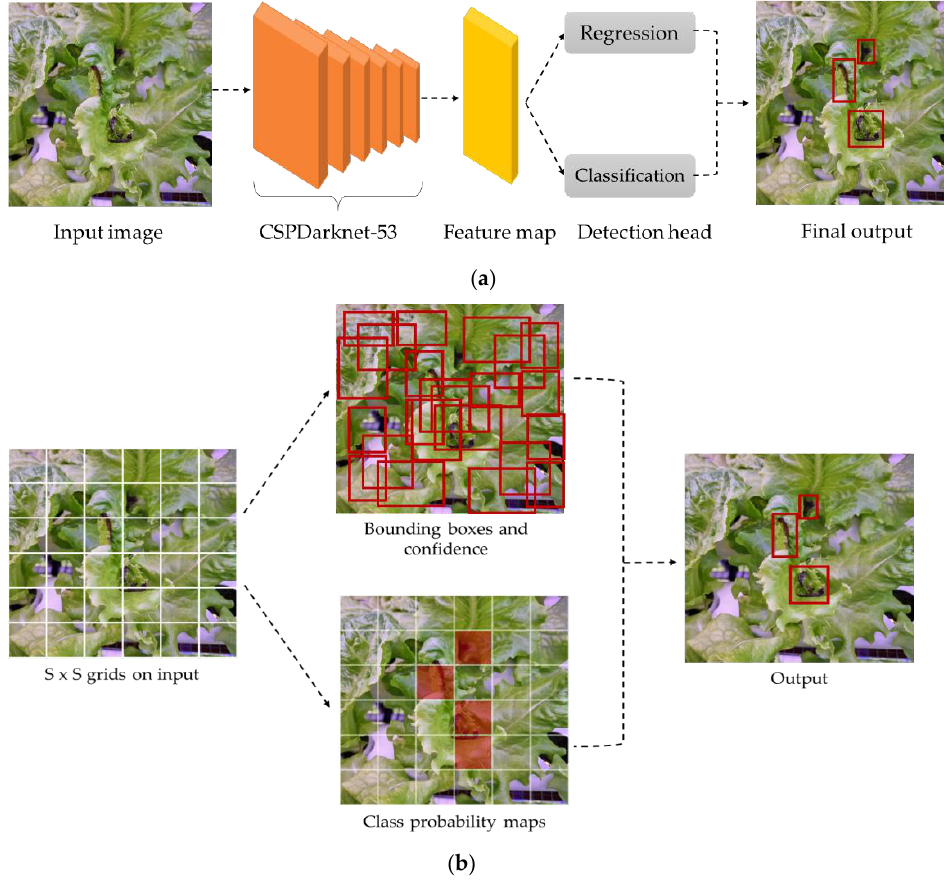
Figure 4. Working principle of the YOLO model: ( a ) detection process of YOLO model based on backbone CSPDarknet-53; ( b ) tip-burn detection based on bounding boxes.